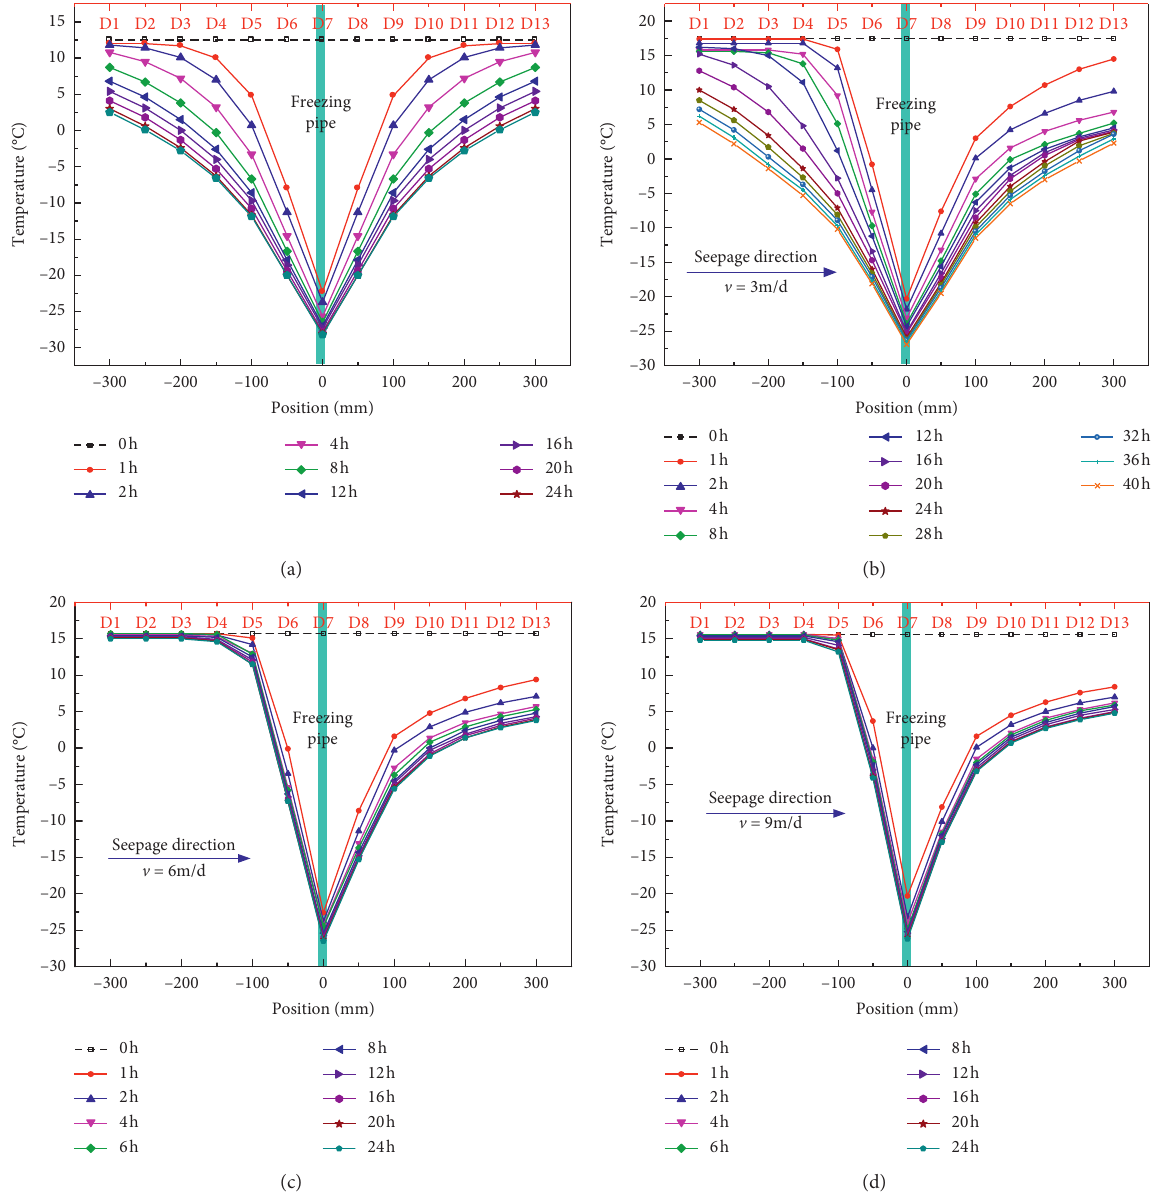
Figure 4: Spatial distribution of temperature on the D axis under the action of seepage field with a flow rate of (a) 0, (b) 3, (c) 6, and (d) 9 m/